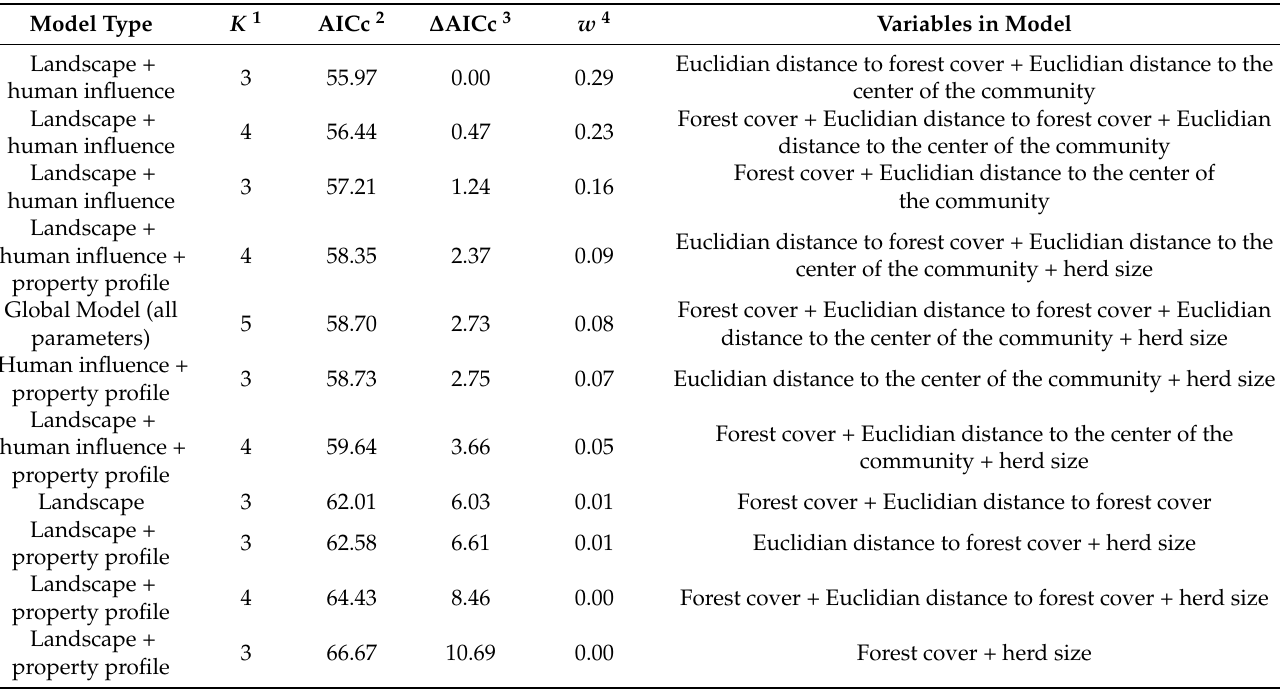
Table 3. Model selection statistics to test overall model